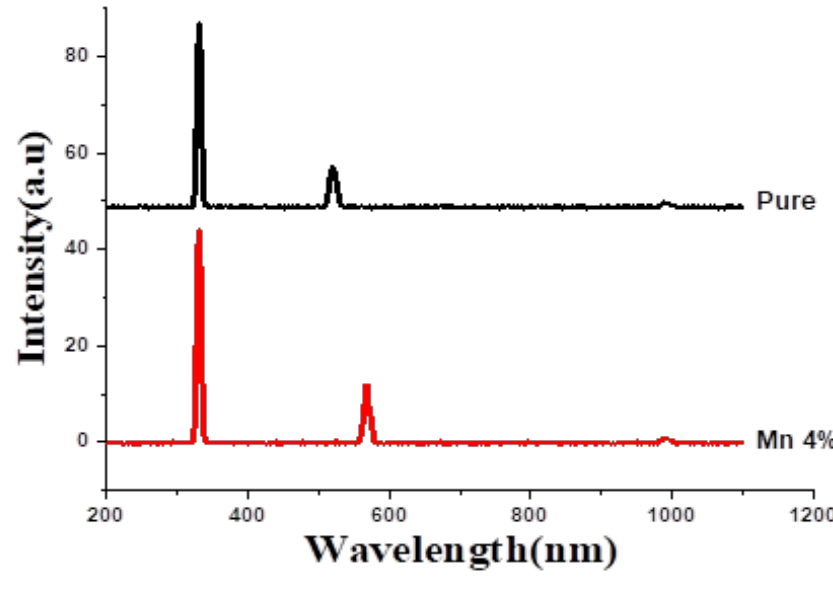
Figure 5 : Photoluminescence spectra for the Pure CdS and doped CdS by Mn